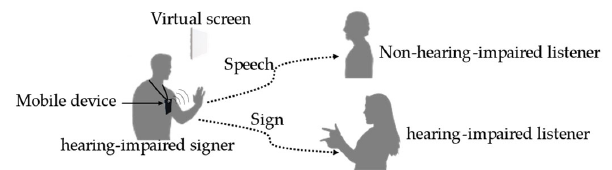
Figure 5. Scenario of the use of a sign ‐ language interpretation device.